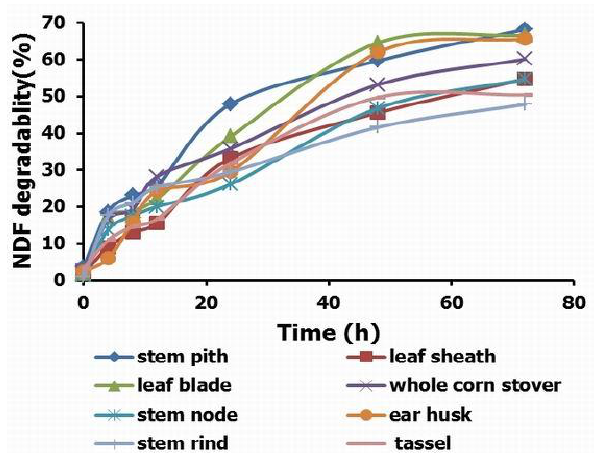
Figure 2. Neutral detergent fiber degradability of whole corn stover and different morphological fractions during rumen incubation for different periods in dry